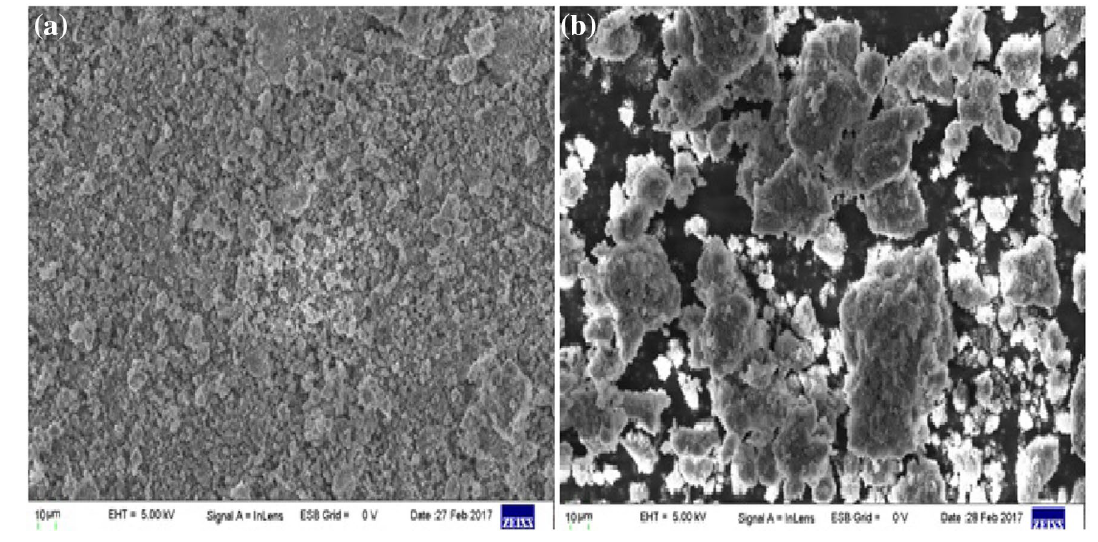
Fig. 9 SEM images of BaSO 4 without inhibitor (a) and with inhibitor